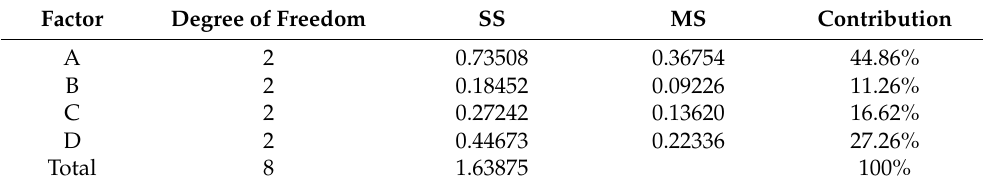
Table 7. Variation and contribution analysis of Vickers Hardness of UNS31803 duplex stainless steel.